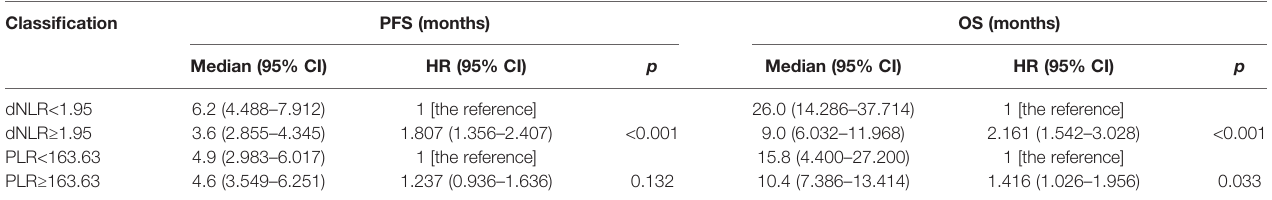
TABLE 3 | Survival of dNLR and PLR.